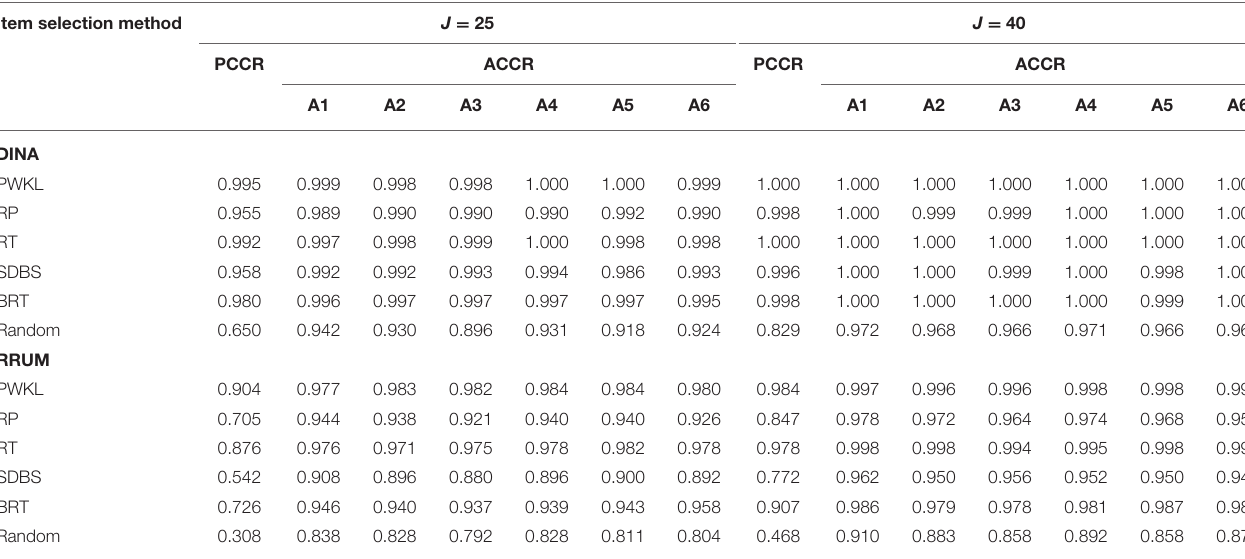
TABLE 2 | The correct classification for six